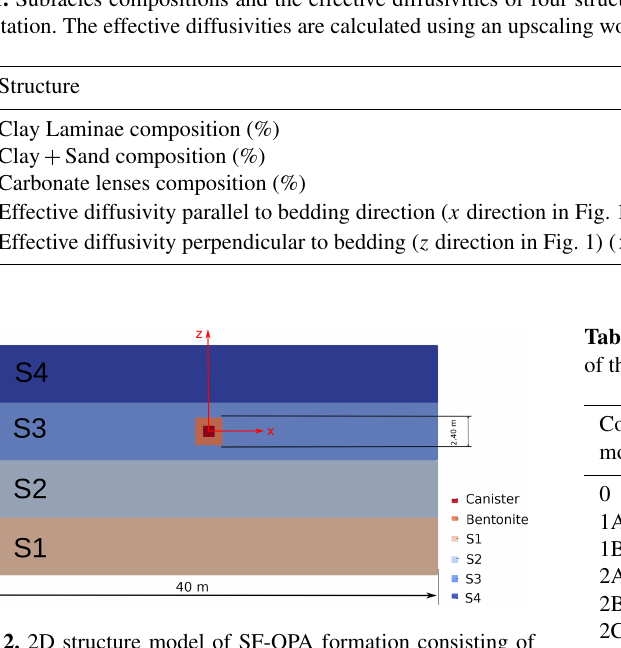
Figure 2. 2D structure model of SF-OPA formation consisting of four different sedimentary layers. The structures of fours layers (S1–S4) are illustrated in Fig. 1. The canister covered (red color) with bentonite buffer (orange color) is placed in the center of layer S3.